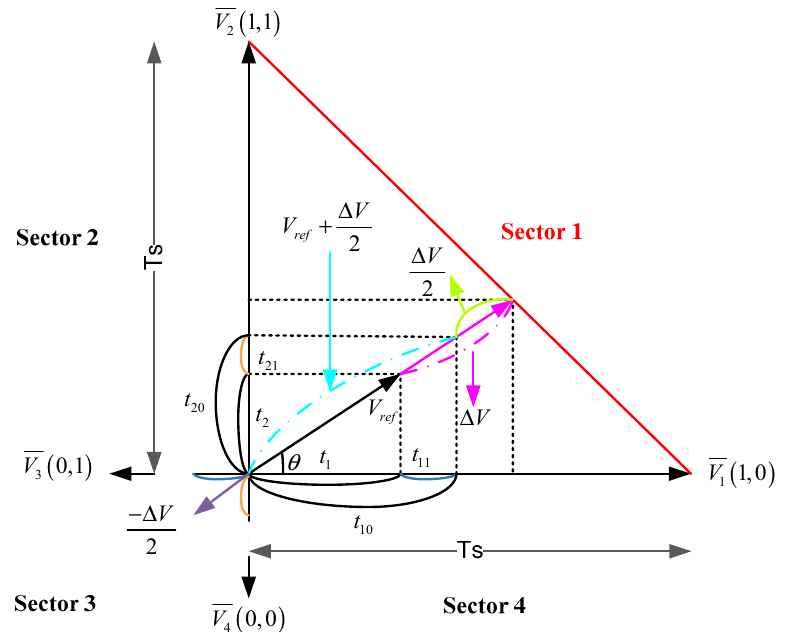
Figure 4. Switching times determined by the two-phase inverter SVM technique. The sectors are divided into two voltage space vectors which are adjacent to the V ref in each case. Two associated time durations spent on the two voltage space vectors are used. However, the two time duration amounts do not satisfy the constant sampling interval T s for allowing the reference vector to arrive at the maximum voltage locus. Accordingly, since there are no zero vectors, the sampling interval remainder should be spent in the main sector and the relevant diagonal sector. Considering the main sector, which is Sector 1, the time duration amount spent on the modified reference vector is defined as: